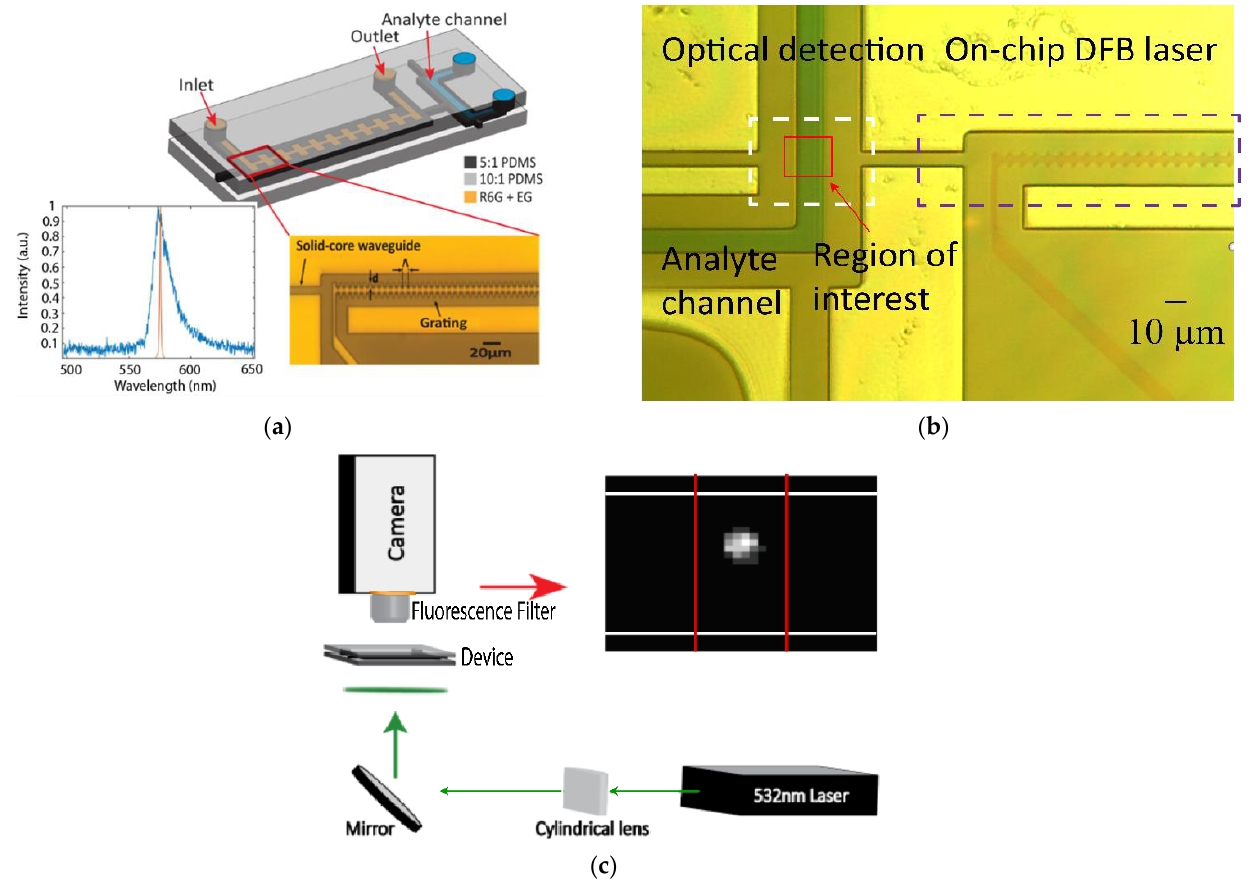
Figure 1. ( a ) PDMS device consisting of on-chip DFB laser integrated with an orthogonal analyte channel via a solid-core waveguide. Inset spectra illustrate lasing (orange) and amplified spontaneous emission (ASE) (blue) output from DFB laser when pumped above and below threshold, respectively. The lasing wavelength occurs at 575 nm. Microscope image shows DFB grating. ( b ) Microscope image of DFB grating filled with red food dye and intersection with analyte channel filled with blue food dye. ( c ) Experimental setup demonstrating optimal external pumping of DFB dye laser using an elliptically shaped 532 nm laser and camera collection of fluorescent signals through a 594 nm long pass fluorescence filter that is placed immediately before the camera. Camera image shows an example of a fluorescent microsphere imaged by the camera sensor. White lines indicate the bounds of the liquid-core analyte channel. Red lines indicate the bounds of the excitation waveguide.